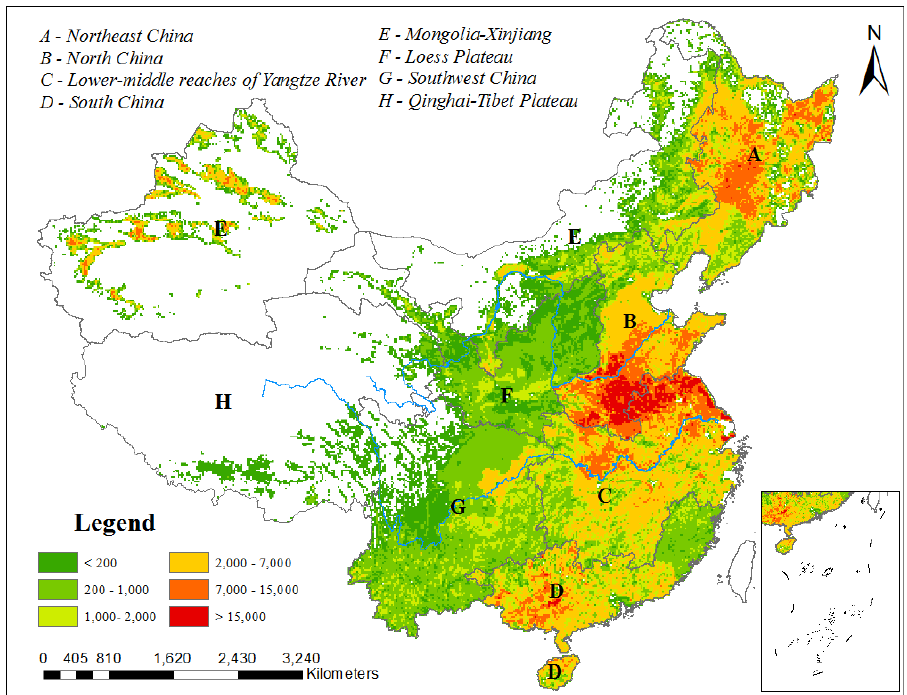
in 2010 (t/10 km 2 E